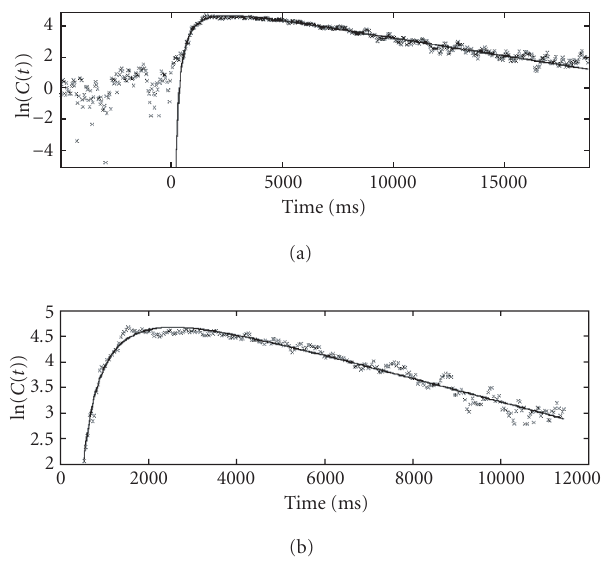
Figure 6: Linear fitting of ln[ C ( t )]. (a) The fitting in the complete time domain with t 0 = 0. Note that C ( t ) does not go to −∞ when t → 0 because of the noise. Re[ln[ C ( t )]] is plotted for negative val- ues of C ( t ). (b) The time interval where the multiple linear regres- sion is performed.